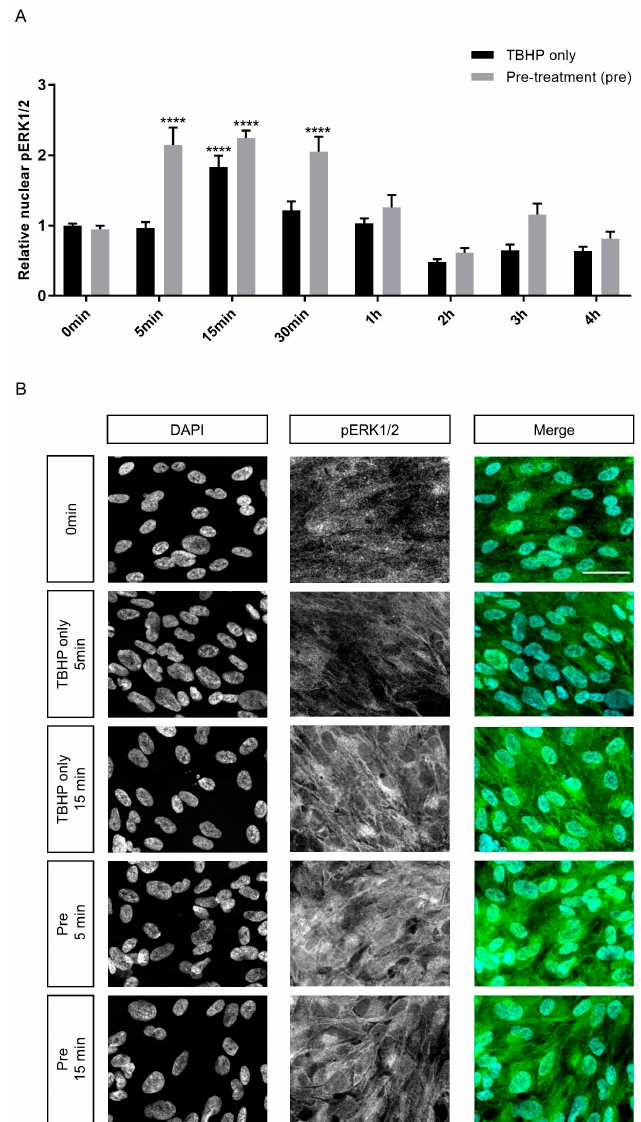
Figure 1. Effect of crocetin on extracellular signal-regulated kinase 1/2 (ERK1/2) activation in ARPE19 cells. ERK1/2 phosphorylation was investigated at different time points (5, 15, 30 min and 1, 2, 3, 4 h) during 4 h exposure to TBHP. ARPE19 cells were only exposed to TBHP or were additionally pre- treated for 24 h with crocetin. While ERK1/2 showed activation and nuclear translocation in the